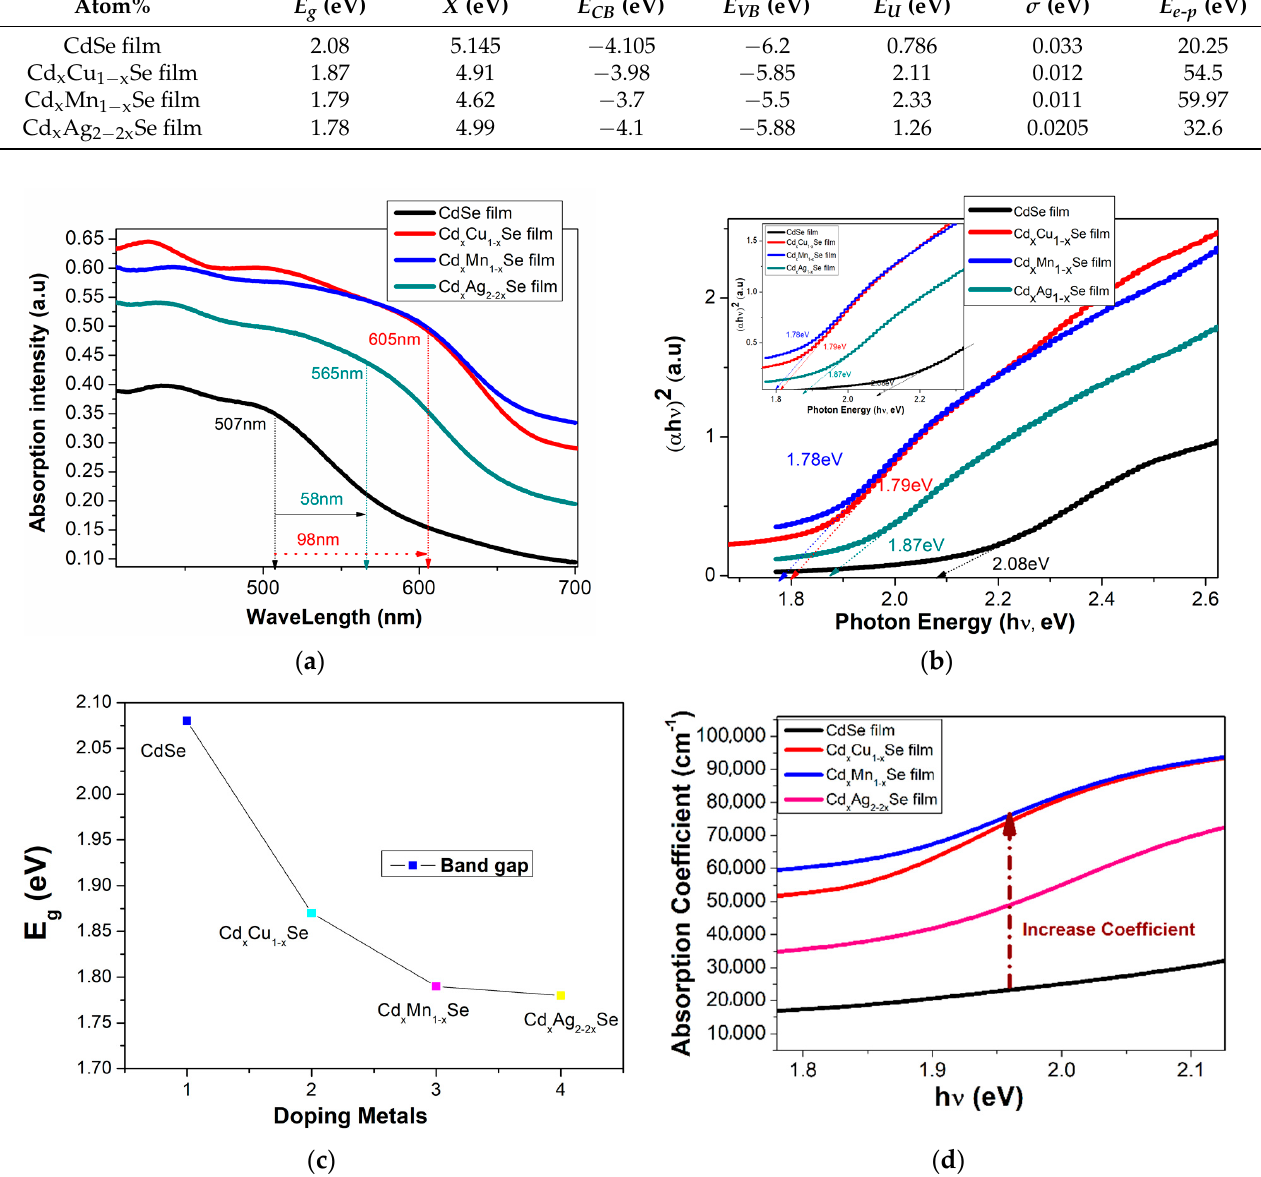
Figure 3. Variation in ( a ) the absorption spectra and ( b ) ( α h ν ) 2 plots with the changing Ag ratio and the dependence of ( c ) E g and ( d ) the absorption coefficient on the compositional TiO 2 /CdS/CdxCu 1 − x Se, and TiO 2 /CdS/Cd x Mn 1 − x Se, and TiO 2 /CdS/Cd x Ag 2-2x Se thin films.